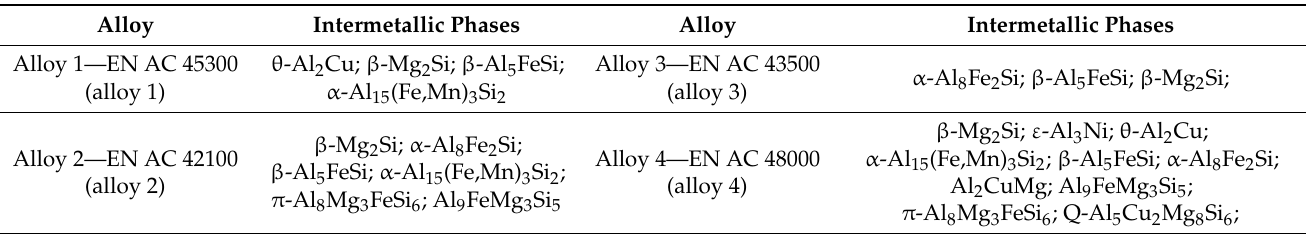
Table 1. Intermetallic phases expected in the alloys studied from literature [32–35]. Alloy Intermetallic Phases